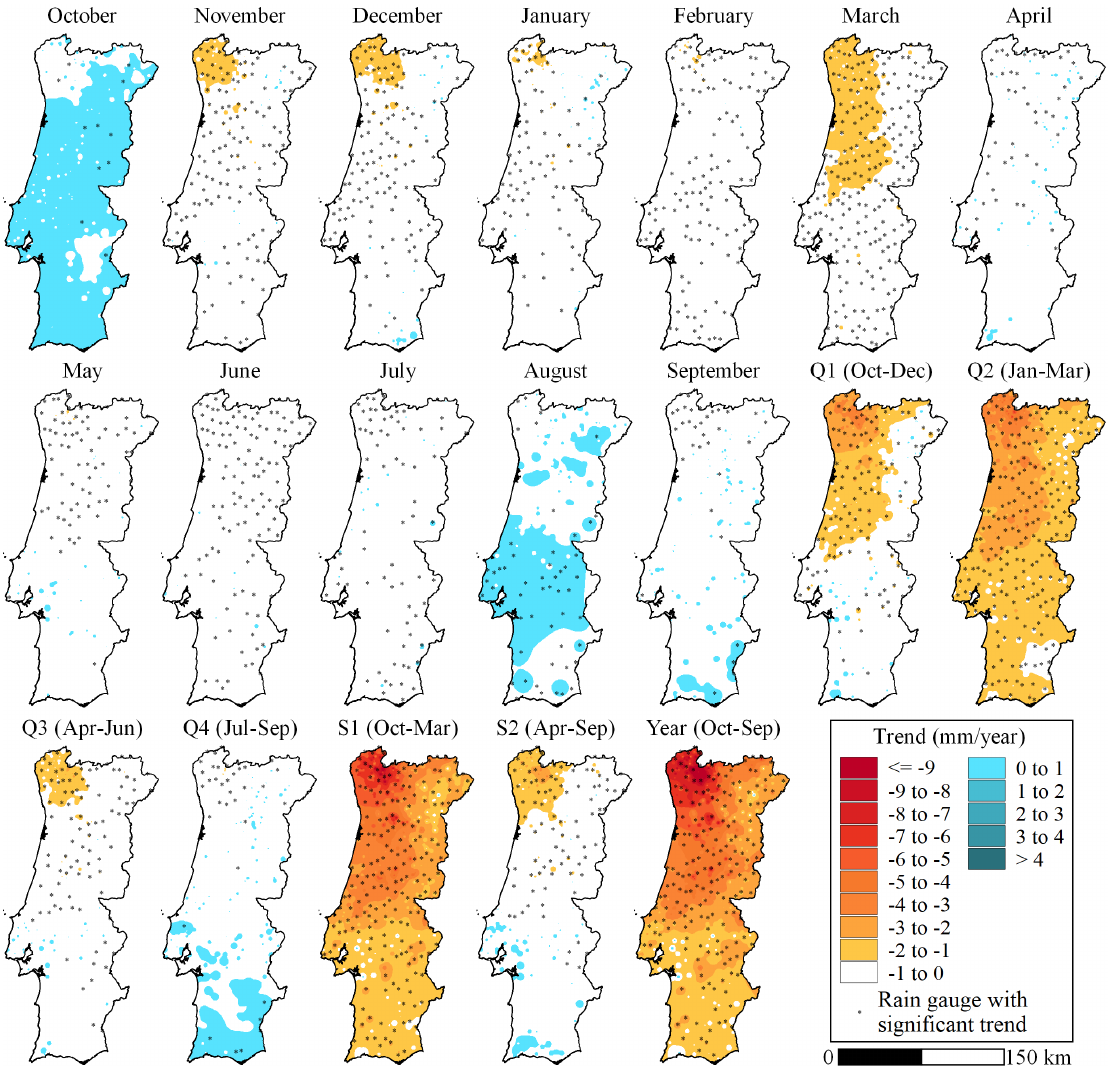
Figure 6. Spatial distribution of the Sen’s slope for the monthly, quarterly (Q1 to Q4), semi-annual (S1 and S2) and annual rainfall in the global period, from 1913/1914 to 2018/2019 (106 years). Only the rain gauges with significant trends are schematically located in the